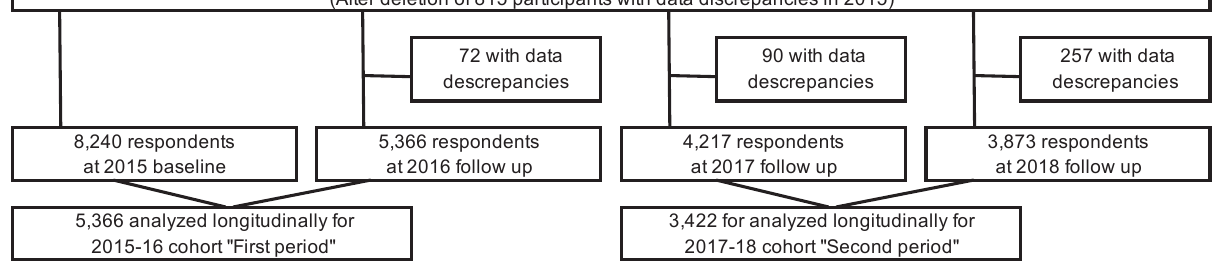
Fig. 1 Flow chart of participants selection for the